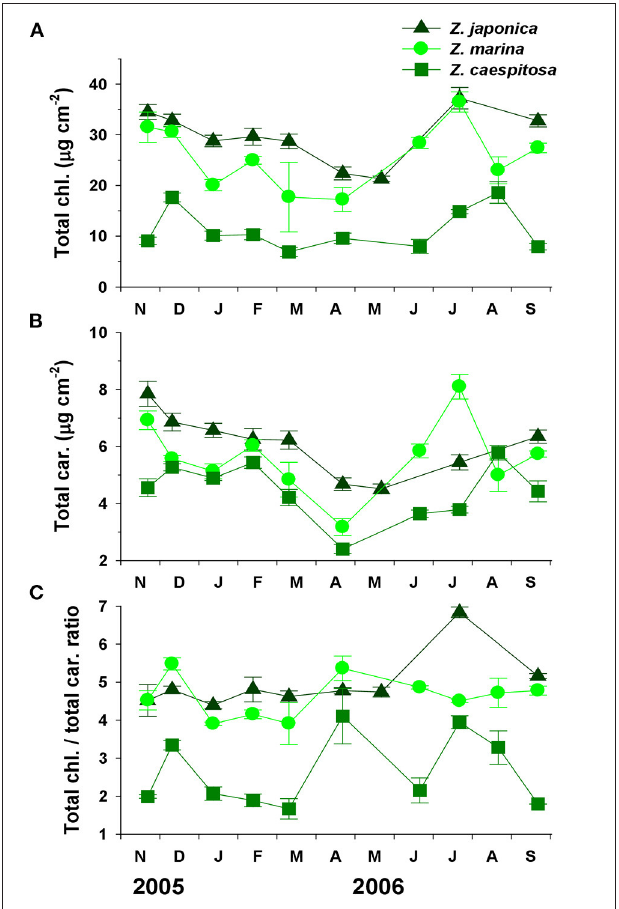
FIGURE 4 | Three Zostera species ( Z. japonica , Z. marina , and Z. caespitosa ). Seasonal changes in total chlorophyll (A) , total carotenoids (B) , and total chlorophyll/total carotenoids ratio (C) in Koje Bay. Values are expressed as mean ± SE ( n = 6).